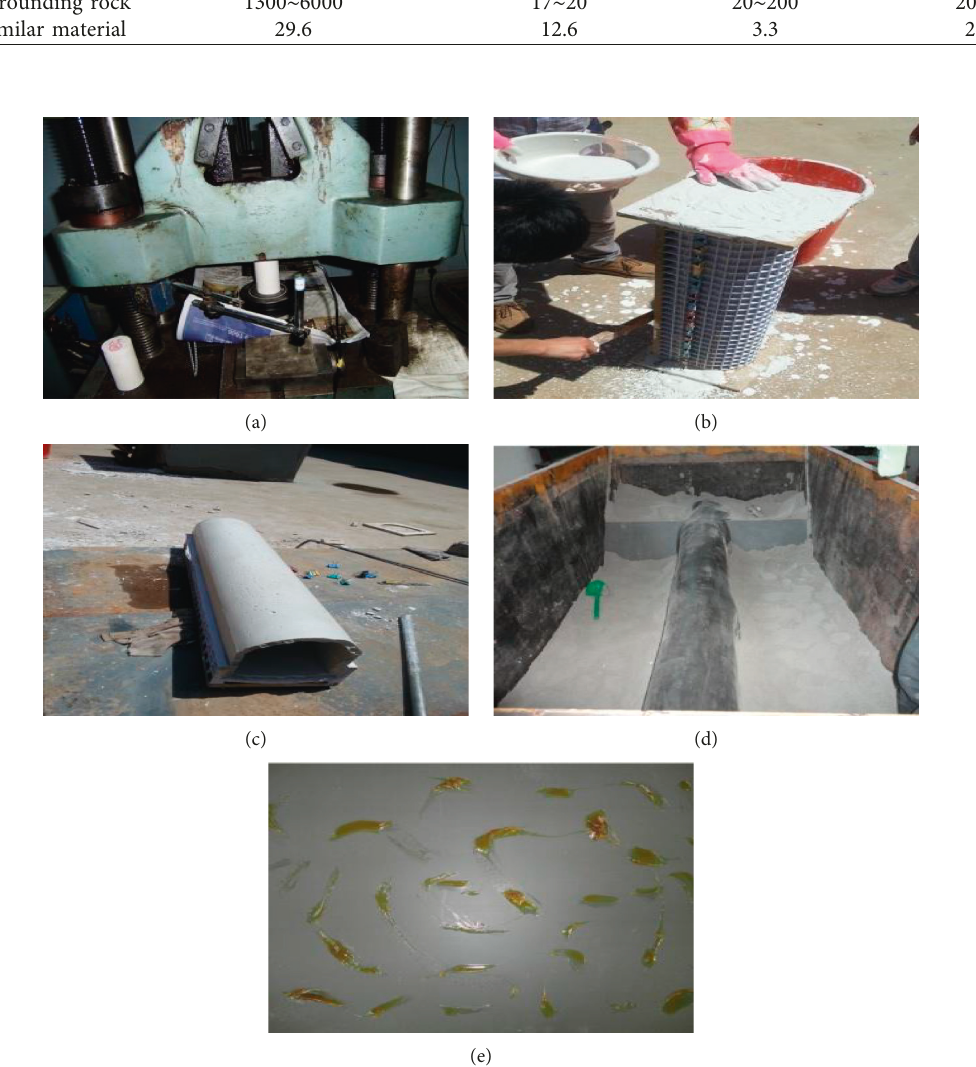
Figure 4: Test similar material. (a) Mechanical testing of lining similar materials. (b) Secondary lining model pouring. (c) Dismantling of the secondary lining model. (d) Foamed rubber plate simulating the reducing dislocation layer. (e) Simulation of the stick-slip fracture.